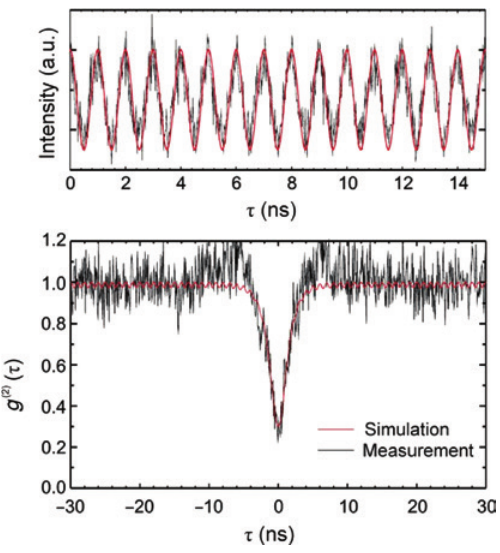
Figure 8: (Top) Optical response of a SPE to an electrical 1-GHz signal with a pulse width of 350 ps and simulation of a pulse train with 400 ps width (red line). (Bottom) Correlation measurement at the same frequency demon- strates clear antibunching. The red line is a simulation of a pulsed perfect single-photon device ( g (2) (0) = 0) with 1-GHz repetition rate, taking into account the limited time resolution of 0.7 ns of the setup, from Refs.